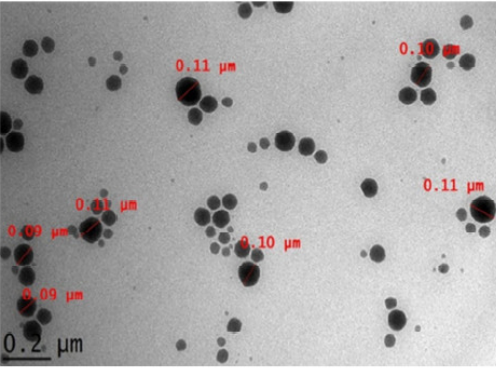
Figure 5. Quercetin-loaded palm-based nanoemulsion in TEM image [42]. “Reproduced with permission from reference”.